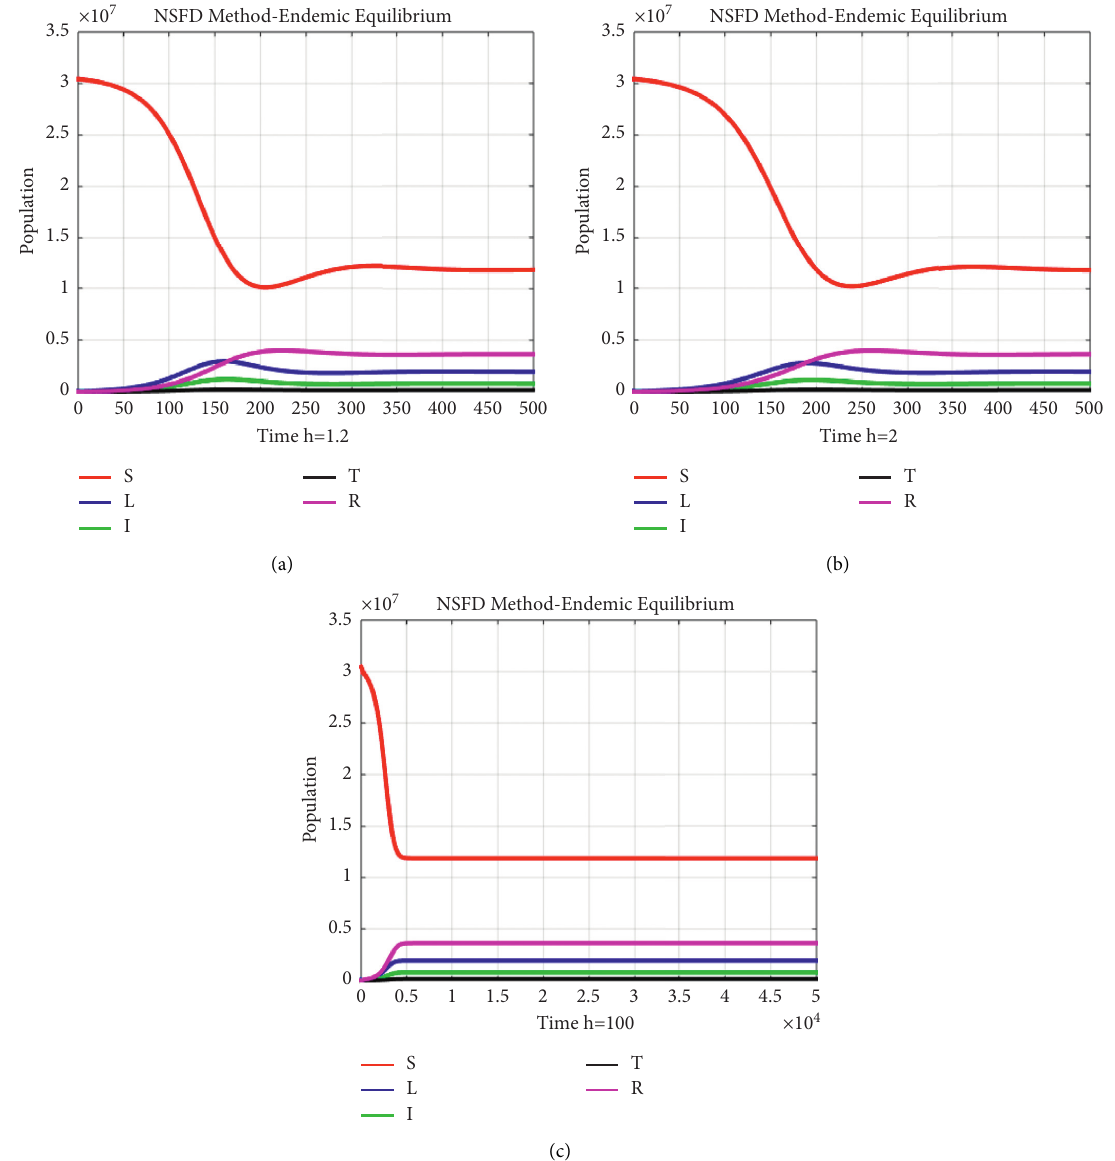
Figure 4: Simulations of forward Euler at endemic equilibrium for h � 1 . 2, h � 2, and h � 100. (a) Simulations of NSFD. (b) Simulations of NSFD (c) Simulations of